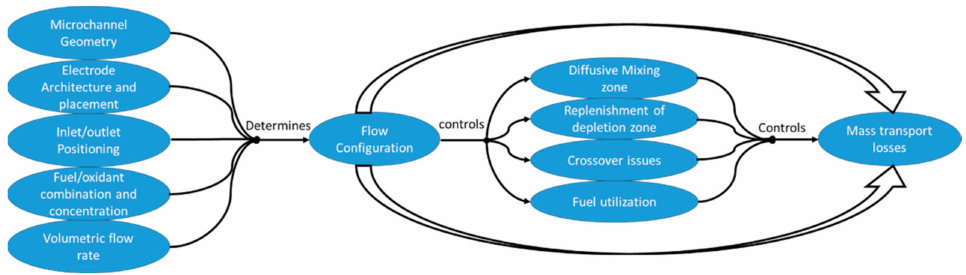
Figure 1. Concept map for the impact of flow configuration on the mass-transfer loss in